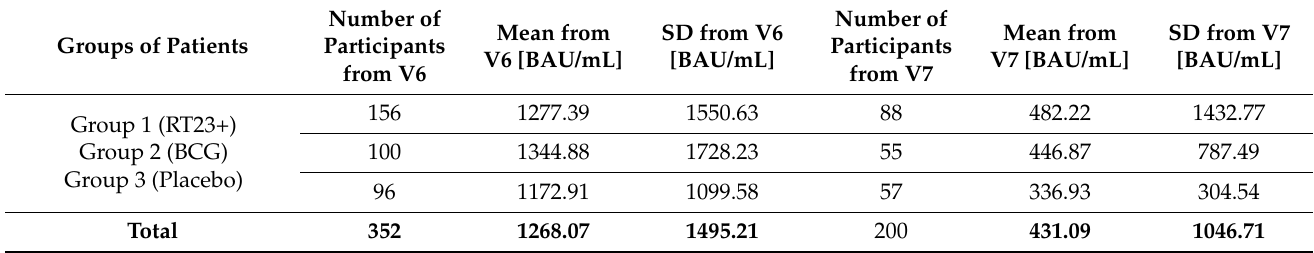
Table 1. Antibody concentrations in the three study groups.